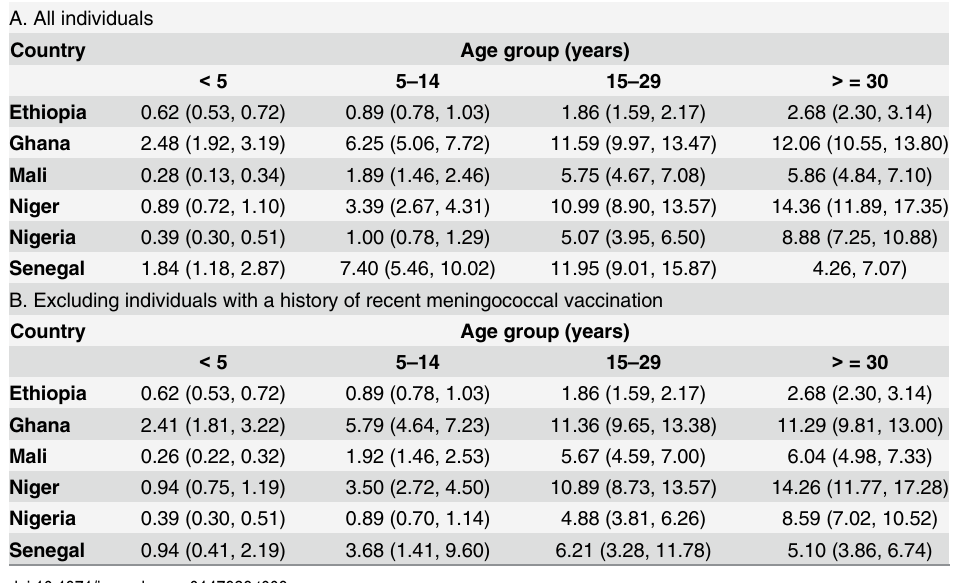
Table 3. Geometric mean meningococcal serogroup A IgG antibody concentrations (95% CI) by age and